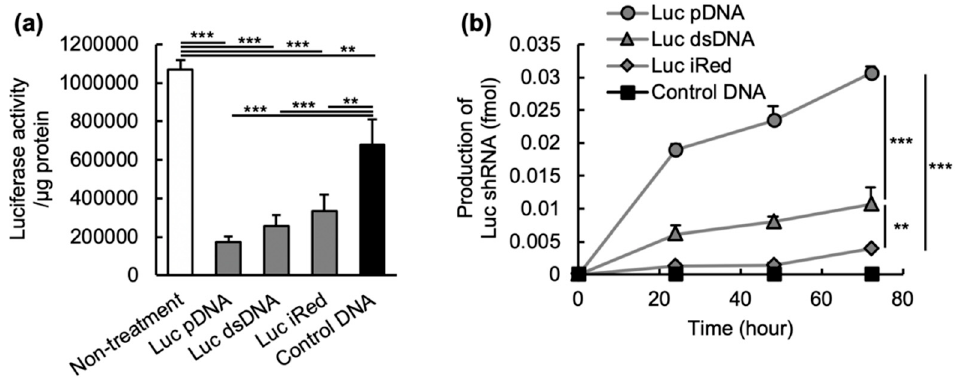
Figure 2. In vitro luciferase gene silencing activities of different DNAs. ( a ) RNAi activity of Luc pDNA, Luc dsDNA, Luc iRed and control DNA. MSTO-211H-Luc cells were transfected with each DNAs using Lipofectamine ® 2000 at 0.5 pmol/well according to the following procedure: 2.1 µg Luc pDNA, 0.115 µg Luc dsDNA or 0.115 µg Luc iRed was mixed with 10 µL Lipofectamine ® 2000 reagent and then transfected into the cells. Data are reported as mean ± SD ( n = 3). Significant differences are represented as ** p < 0.01, *** p < 0.001. ( b ) The amount of shRNA molecules transcribed from different DNAs. The shRNAs were extracted from the cells post-transfection with DNAs using a Lipofectamine ® 2000 reagent (0.5 pmol/well) at the indicated time points. The procedure to transfect the DNAs into cells was the same as Figure 2a. Data are reported as mean ± SD ( n = 3). Significant differences are represented as ** p < 0.01, *** p < 0.001.